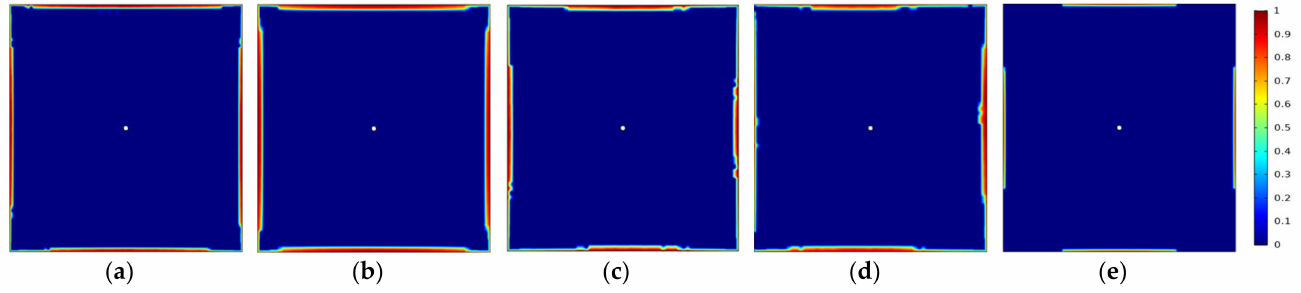
Figure 9. Coal rock shear damage D . ( a ) m = 0; ( b ) m = 0.5; ( c ) m = 0.8; ( d ) m = 1.1; ( e ) m = ∞